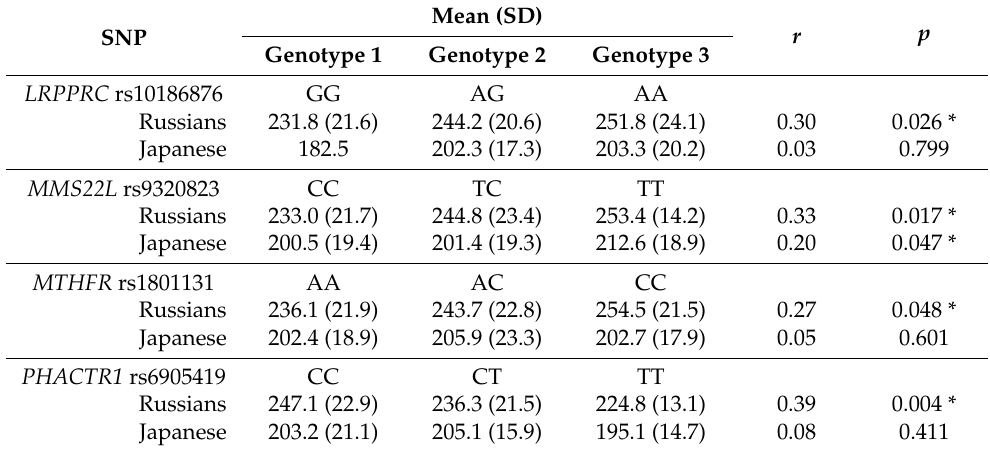
Table 1. Weightlifting performance in Russian and Japanese athletes across